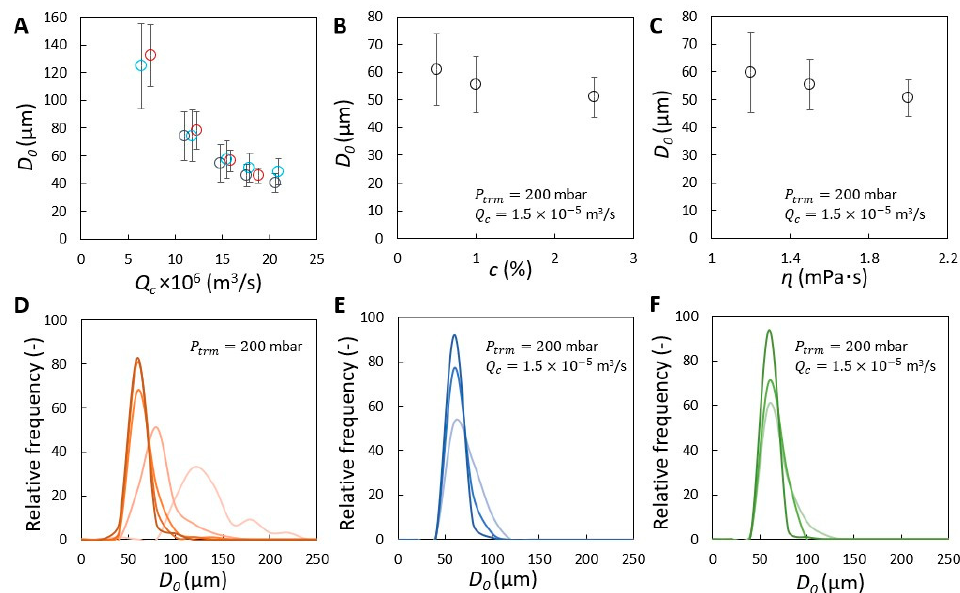
Figure 4. Properties of bubbles (with D 0 ) formed at the membrane surface. ( A ) Shear effect investi- gated for P trm equal to 100 (O), 200 (O) and 300 (O) mbar. Results at P trm = 400 mbar are not included, because bubbles that are initially formed at the pores cannot be measured due to bubble crowdedness. ( B ) Protein concentration effect. ( C ) Continuous phase viscosity effect. Corresponding D 0 values of figures ( A – C ) shown as size distribution obtained at P trm = 200 mbar are given in ( D – F ). Darker colors indicate the increase in the evaluated